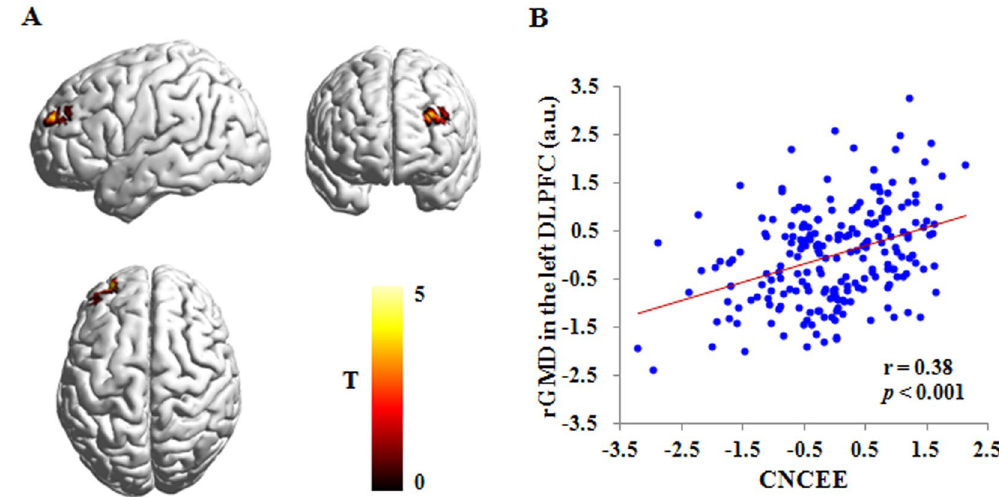
Figure 1. Brain regions that are related to CNCEE. ( A ) Brain images showing the positive association between the rGMD of the left DLPFC and CNCEE. ( B ) Scatter plot depicting the correlation between CNCEE and the rGMD of the left DLPFC (r = 0.38, p < 0.001). The score of horizontal axis represents the standardized residual of the CNCEE score (average standardized score of four curriculum subjects) after adjusting for age, gender and total gray matter volume. The score of vertical axis represents the standardized residual of the rGMD in the left DLPFC after adjusting for age, gender and total gray matter volume. The color bar represents the Student’s T-test (T) scores in each voxel, 0 represents the minimum T score and 5 represents the maximum T score. rGMD = regional gray matter density; DLPFC = dorsolateral prefrontal cortex; a.u. = arbitrary